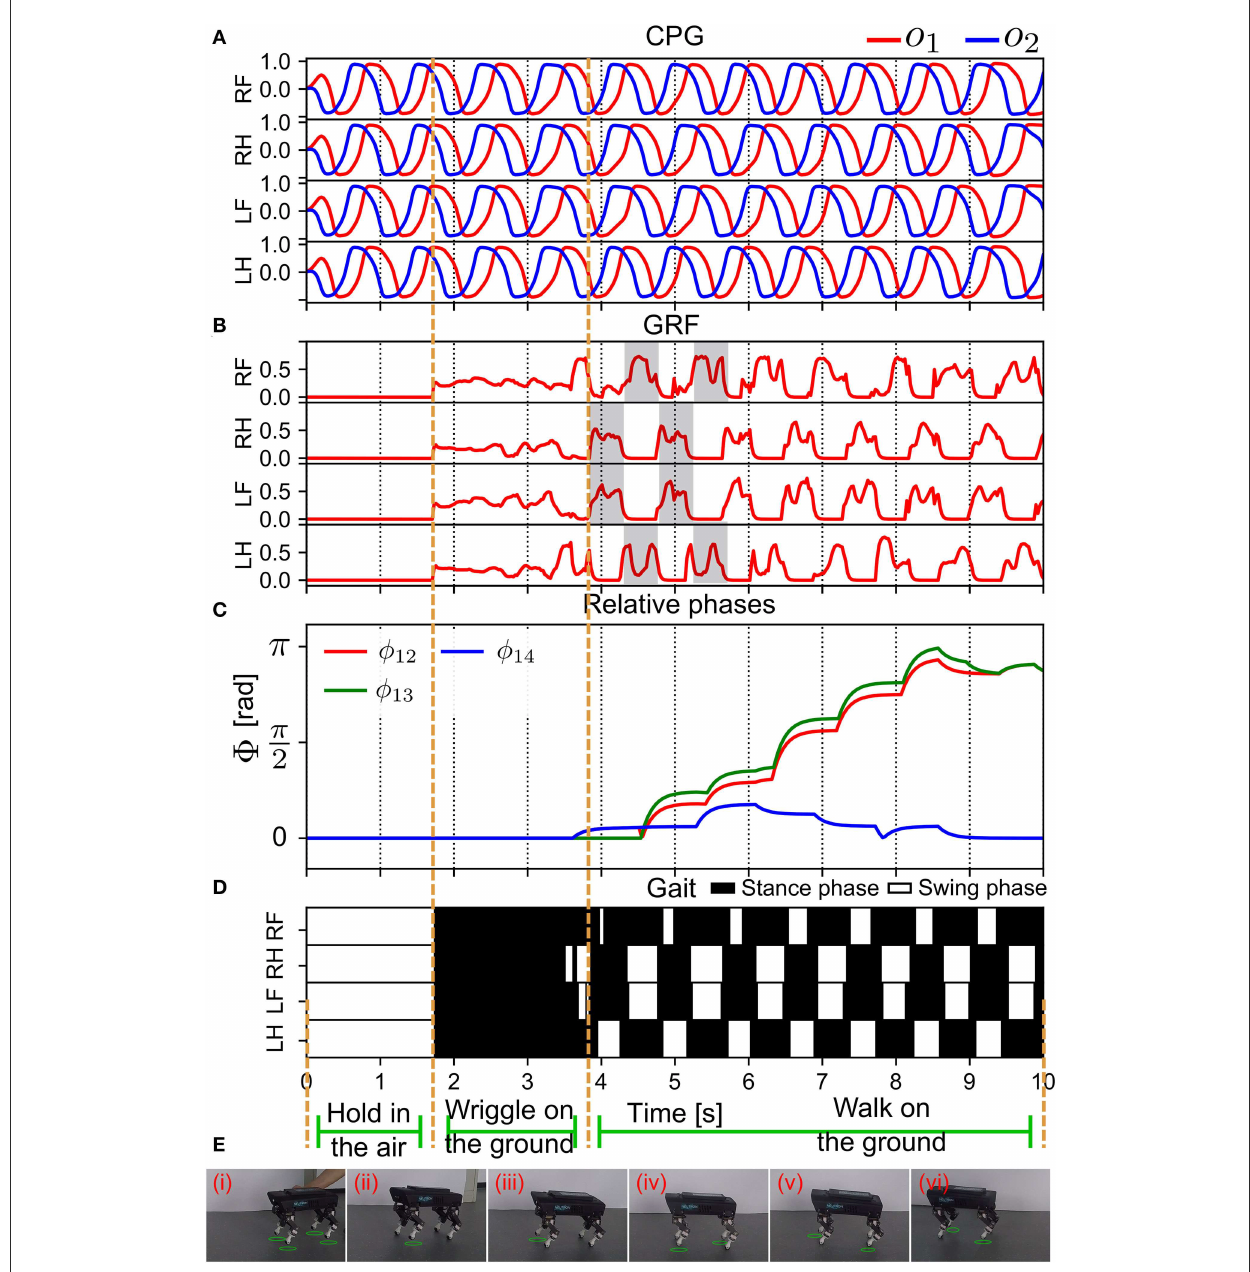
FIGURE10 Real-time data of the self-organized locomotion generation (in S1). (A) The outputs of all the CPGs. (B) The GRF feedback to the CPGs. The GRF periodic pattern appeared after 4 s. (C) The relative phases between the CPG signals (see Equation 13). (D) Gait diagram. (E) Snapshots of Lilibot exhibiting self-organized locomotion. A green circle under a foot indicates that the foot was in a swing phase. Lilibot was suspended in midair in (i), and was placed on the ground in (ii), after which it began to form a gait from (iii) to